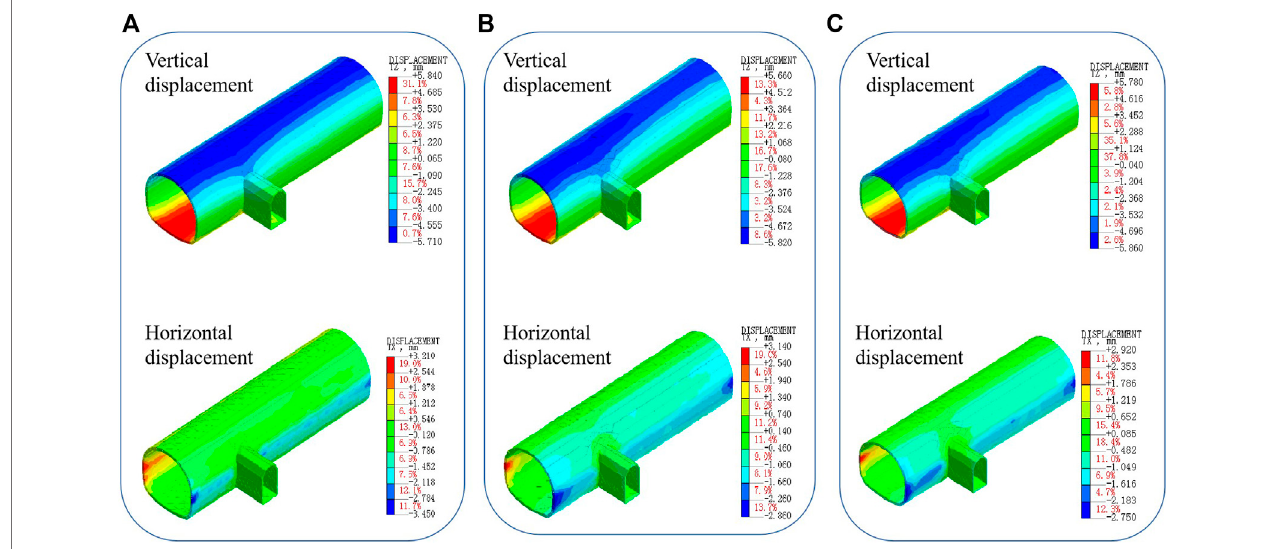
FIGURE 3 | Displacement nephogram after construction (A) The double-holes interval pillar method, (B) the sector expansion method, and (C) the gate climbing method.